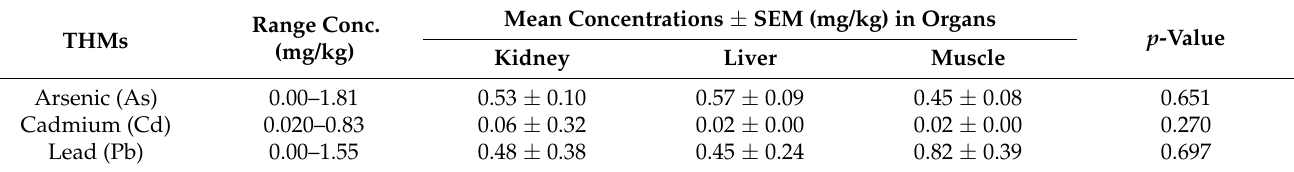
Table 5. Mean concentration of toxic heavy metals (THMs) specific to organs of goat carcasses processed for human consumption in Enugu State,